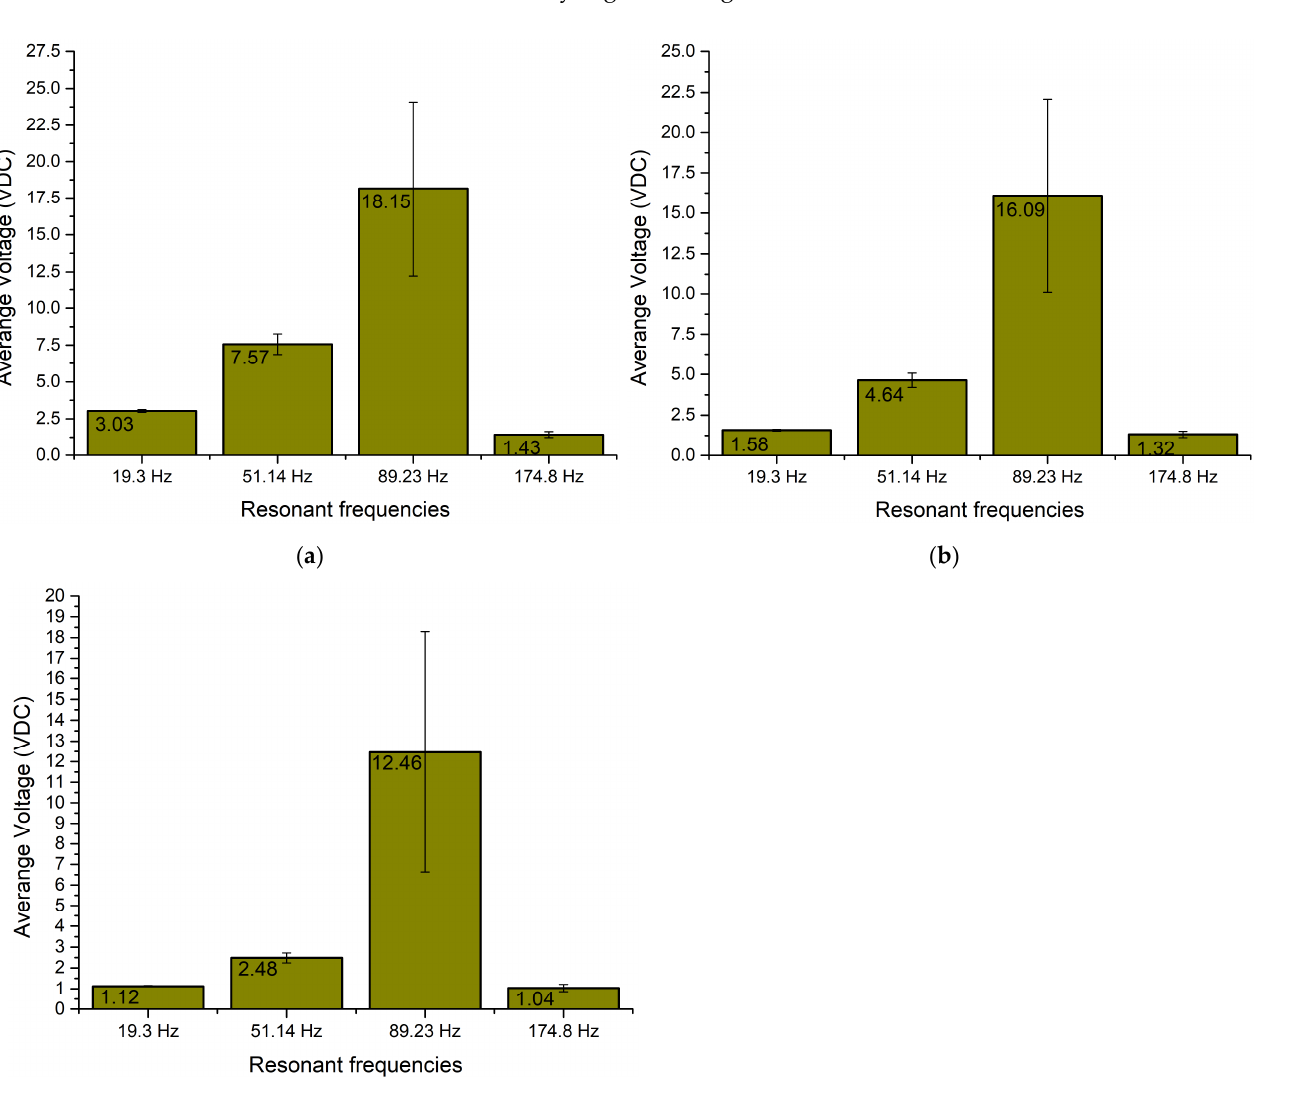
Figure 6. Frequency—voltage—angle of excitation characteristics of the energy harvester with dif- ferent loads; ( a )—load equal to 1 MΩ; ( b )—load equal to 500 kΩ; ( c )—load equal to 250 kΩ. As can be found in Figure 7, the average voltage values at the first, second and fourth resonance frequencies are stable and have low deviations. On the other hand, the average output voltage value obtained at the third resonance has a notable deviation. In general, it is influenced by the modal shape of energy, and it responds to changes in the angle of input vibration. At particular angles of excitation motion the harvester resonates partly and does not generate the full amount of possible output voltage.